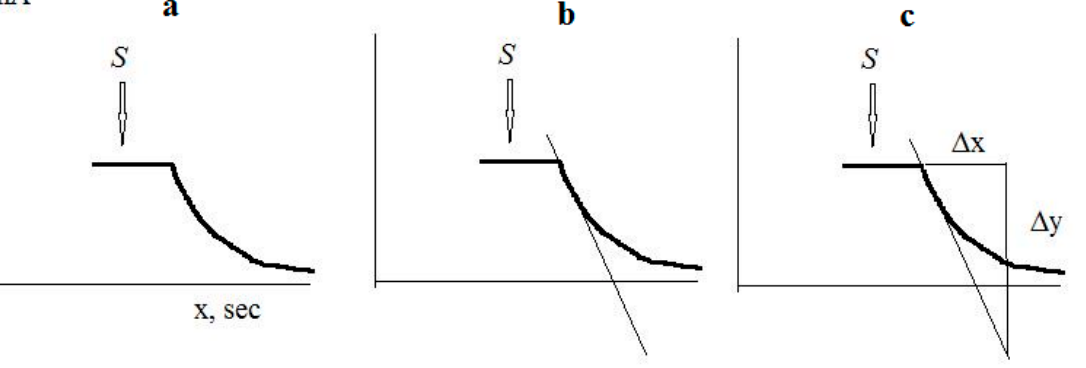
Figure 3. An example of calculation of the response to substrate: ( a ) Registration of the response to a substrate; ( b ) Drawing the tangent with the largest slope to the recorded response curve; ( c ) Construction of a right triangle, where the tangent is the hypotenuse. The arrow shows the moment of substrate injection.